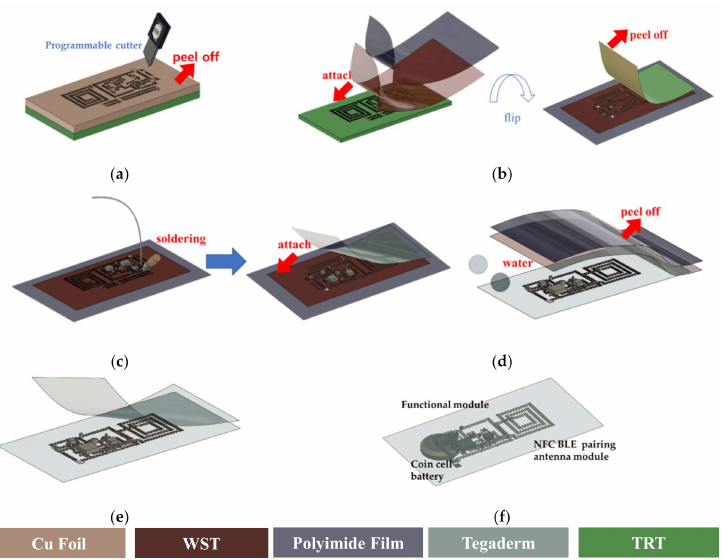
Figure 2. Implementation process patchable IMU. ( a ) Design and formulation of layout footprint; ( b ) water-soluble tape (WST)/polyimide film attachment and thermal release tape (TRT) removal; ( c ) Soldering and top-layer encapsulation; ( d ) Detachment of WST/polyimide film; ( e ) Bottom-layer encapsulation; ( f ) Battery and module